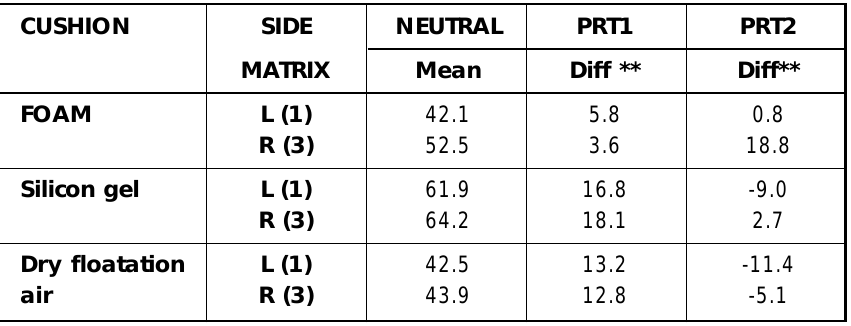
Table 1: A comparison of the mean of the six cells in matrices 1 and 3 that are situated over the ischial tuberosities (measured in mm Hg).